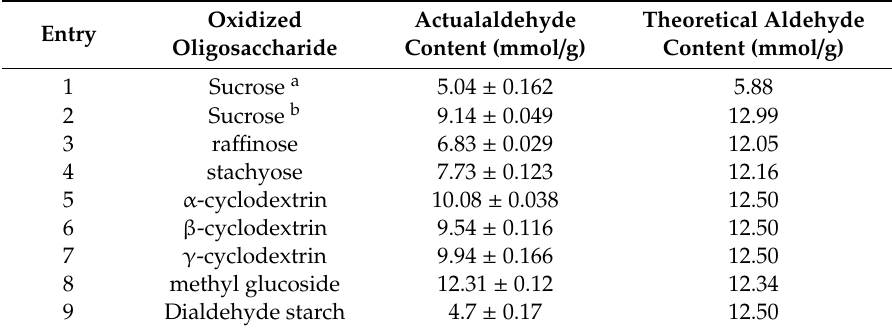
Table 1. Actual and theoretical aldehyde content of the oxidized saccharides. Oxidized Entry Oligosaccharide